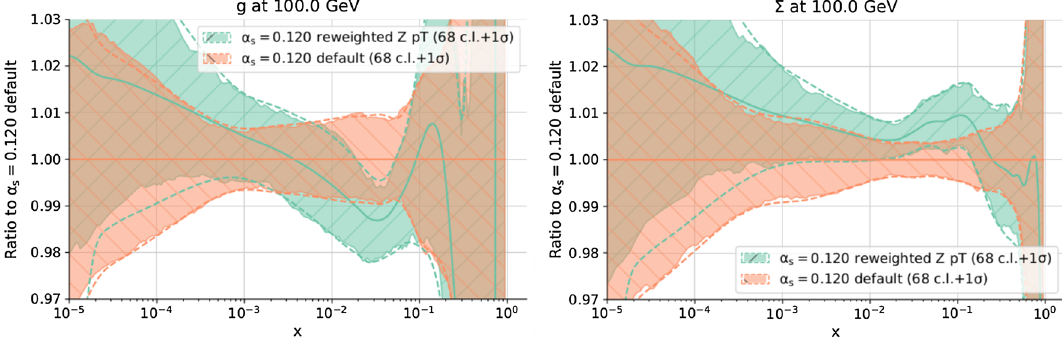
Fig. 3 Comparison between the gluon (left) and quark singlet (right) PDFs in the default global PDF determination (orange, lower band at low x ) and in a PDF determination in which the Z p T data receive a large weight (green, higher band at low x ), shown as a ratio to the